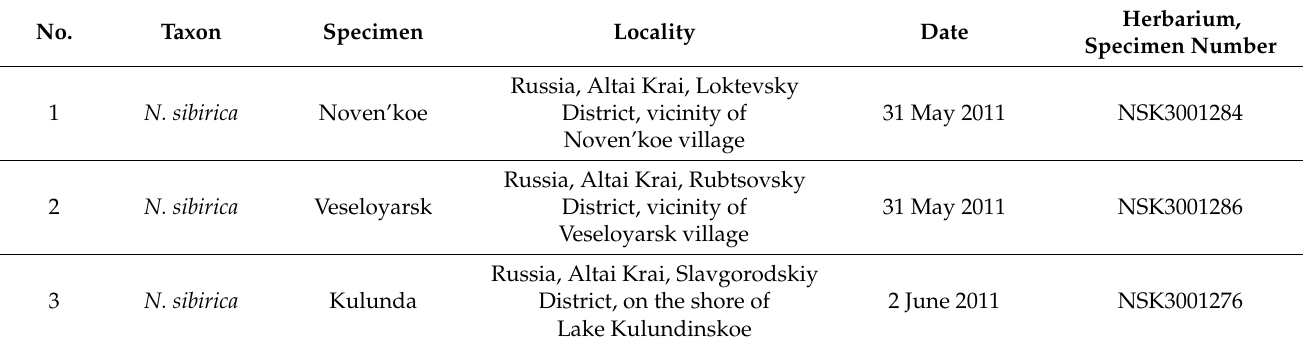
Table 2. Vaucher specimens of Nitraria